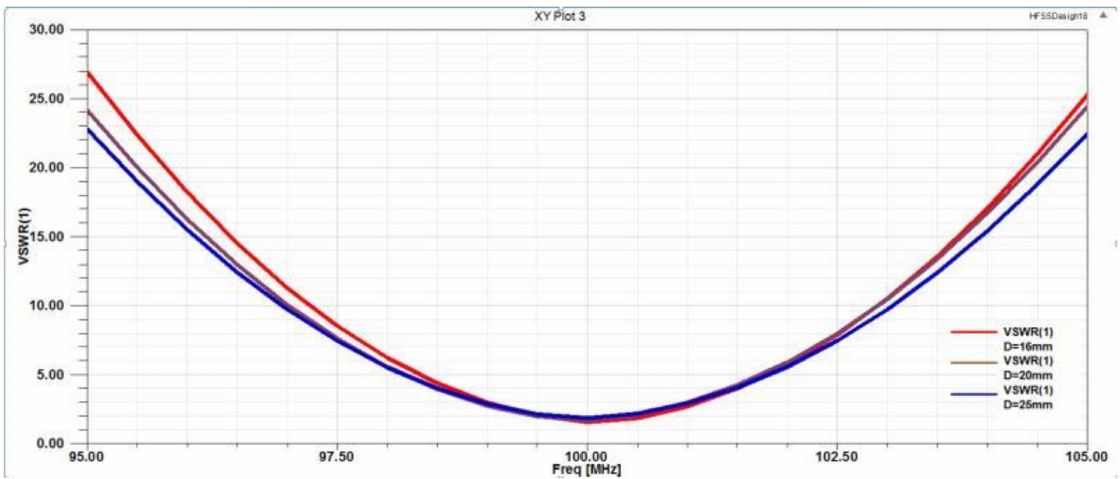
Figure 9. VSWR parameter curves with unit spacings of D = 16, 20, and 25 mm.